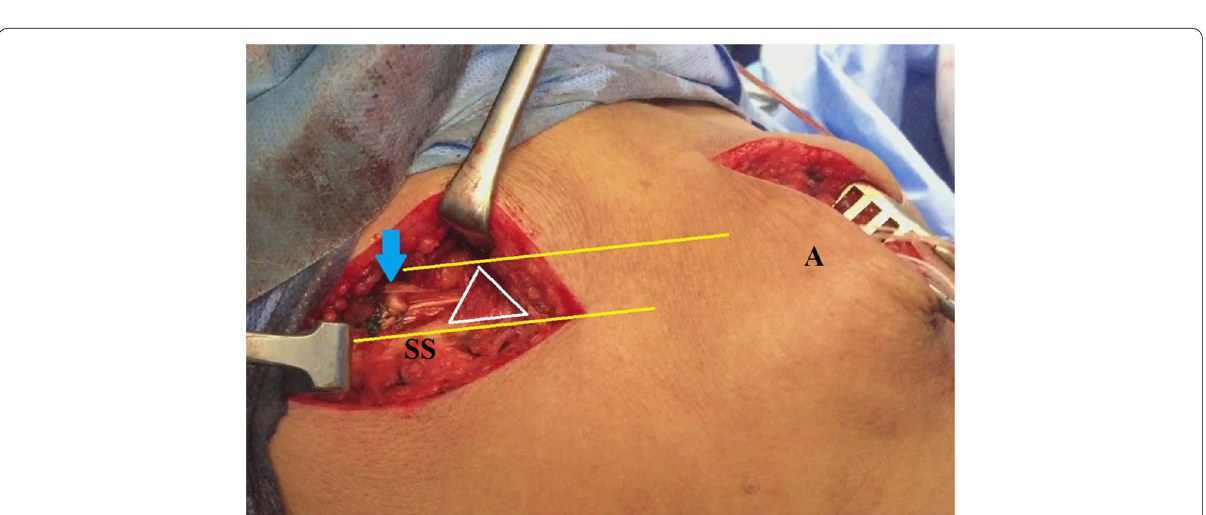
Fig. 13 demonstrates passage of the blue arrow‑marked tendon reconstruct deep to intact lateral part of the middle trapezius insertion (defined in while triangle) prior to its passage under the acromion; and also demonstrates anatomic convenience of supraspinatus fossa (defined between yellow lines) for reproduction of supraspinatus muscle function by the transferred middle trapezius tendon in the right shoulder; A, acromion; SS, scapular